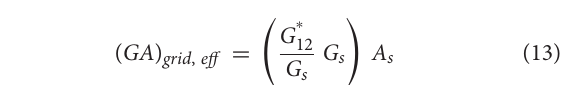
where EI grid , eff and GA grid , eff are the effective bending stiffness and effective shear stiffness of the grid structure, respectively; ( E ∗ ) / E s and ( G ∗ ) / G s are the axial modification factor and 1 12